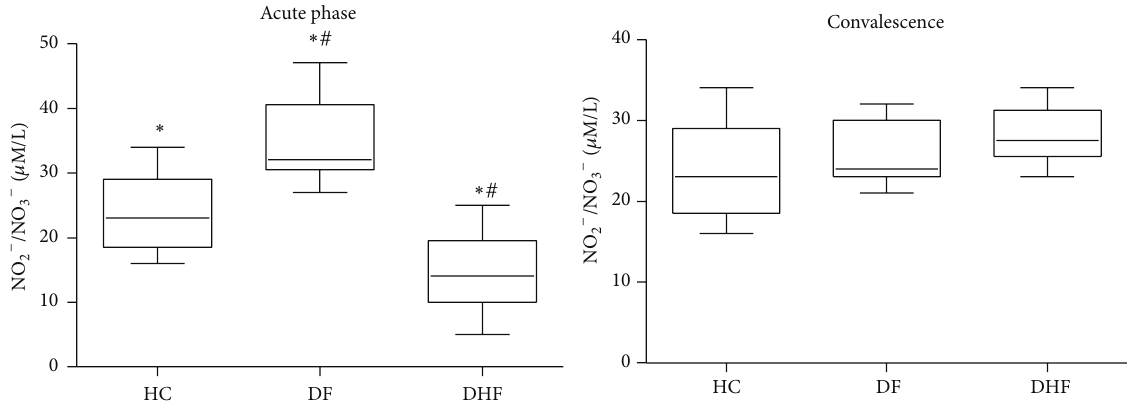
Figure 2: Nitric oxide serum levels ( 𝜇 M of NO 2− / NO 3− ) of patients with dengue fever (DF, 𝑛 = 26 ), dengue hemorrhagic fever (DHF, 𝑛 = 11 ), and healthy controls (HC, 𝑛 = 20 ) measured by Griess reaction after reduction of serum samples with nitrate reductase. Results were expressed as median using a box plot. Equivalent symbols ( ∗ , #) represent statistically significant differences ( 𝑃 < 0.05 ) between two groups.